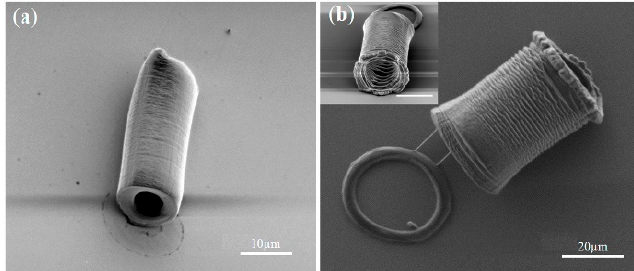
Figure 15. ( a ) PEGDA-based hydrogel tube with a length of ~20 µ m, an outer diameter of ~10 µ m, and an inner diameter of ~5 µ m. ( b ) PEGDA-based hydrogel tube with a length of ~35 µ m, an outer diameter of ~25 µ m, and an inner diameter of ~20 µ m (reproduced from Ref. [82]).